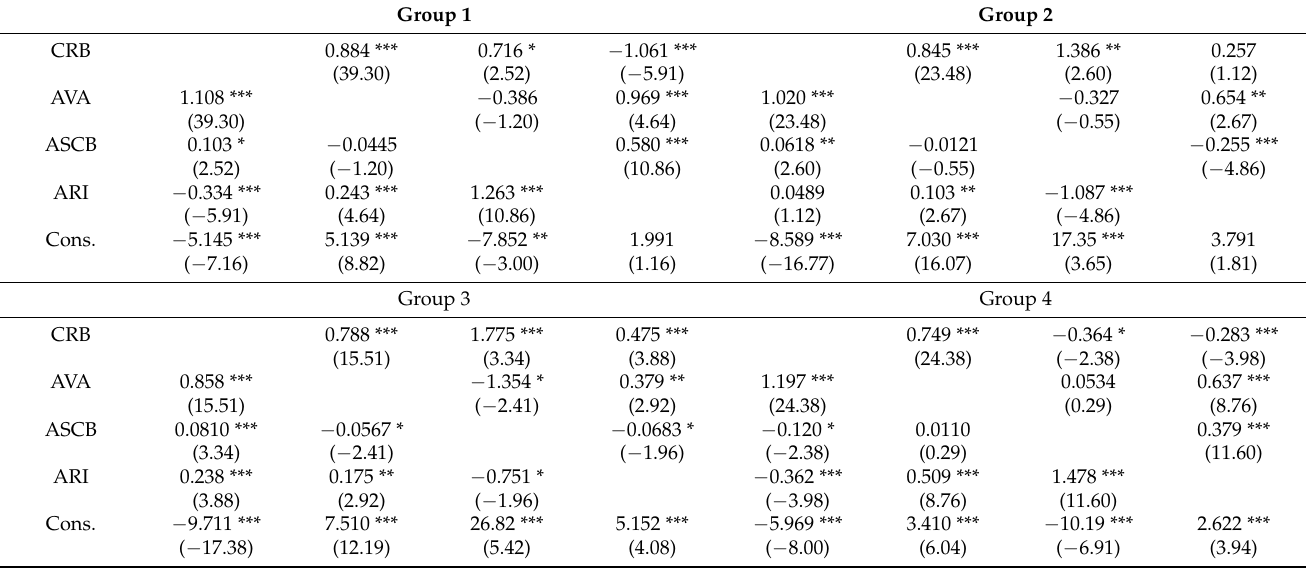
Table 3. Simultaneous equation.